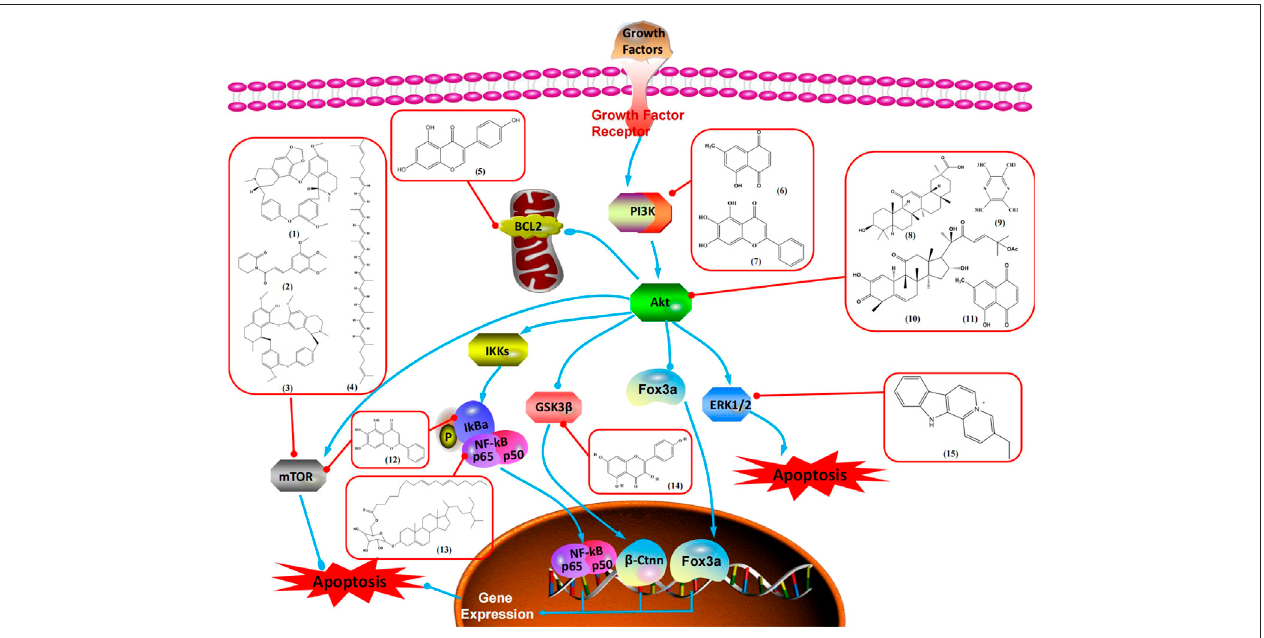
FIGURE3| NaturalproductsinducedapoptosisthroughPI3K/AKTpathway.(1)cepharanthine,(2)piperlongumine,(3)fangchinoline,(4)lycopene,(5)genistein,(6) ramentaceone, (7) baicalein, (8) 18 β -glycyrrhetinic acid, (9) tetramethylpyrazine, (10) cucurbitacin e, (11) ramentaceone, (12) baicalein, (13) daucosterol linoleate, (14) kaempferol, (15) fl